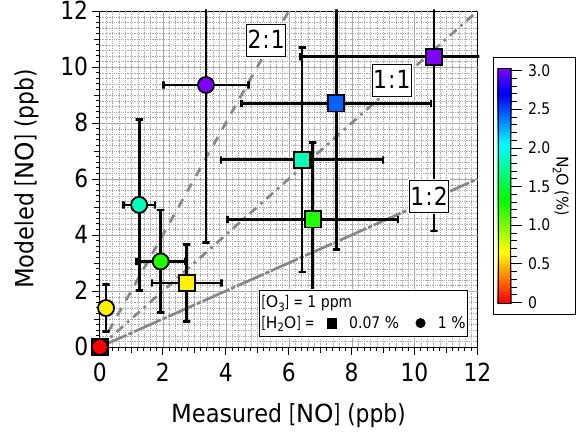
Figure 1. Scatterplot comparing measured and modeled [NO] at 80s residence time in the PAM oxidation flow reactor; I 254 = 4 × 10 15 phcm − 2 s − 1 , [O 3 ] = 1ppm, [H 2 O] = 0.07 and 1%, and [N 2 O] = 0 to 3%. Symbols are colored by [N 2 O], with 1:2, 1:1, and 2:1 lines shown for reference. Error bars represent ± 60% uncertainty in model outputs (Peng et al., 2015) and ± 40% precision in replicate [NO] measurements at fixed [N 2